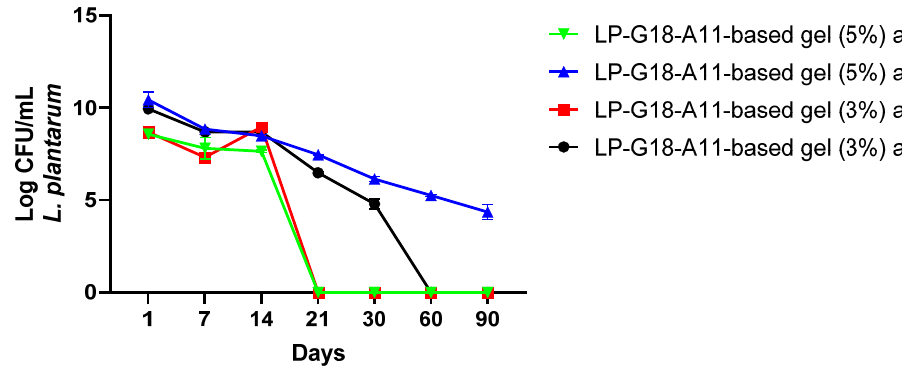
Figure 1. Viability of Lactiplantibacillus plantarum LP-G18-A11 at 3% and 5% in natrosol gels stored for 90 days at 4 ◦ C and 25 ◦ for 90 days at 4 °C and 25 °C.